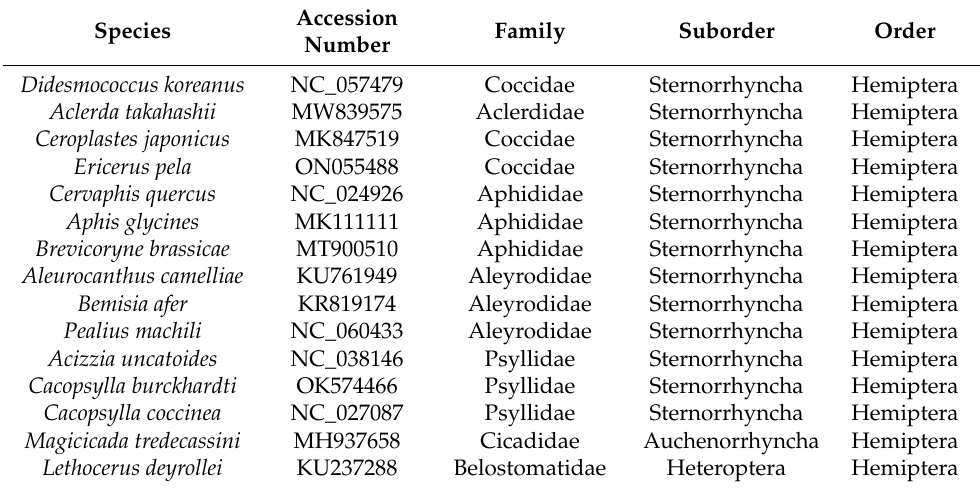
Table 1. The species included in the phylogenetic